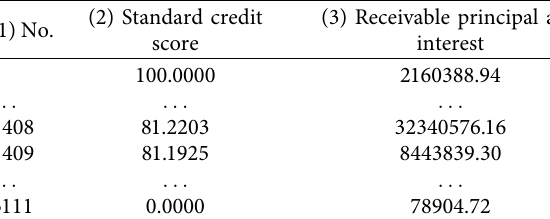
Table 1: Small enterprise credit rating data.